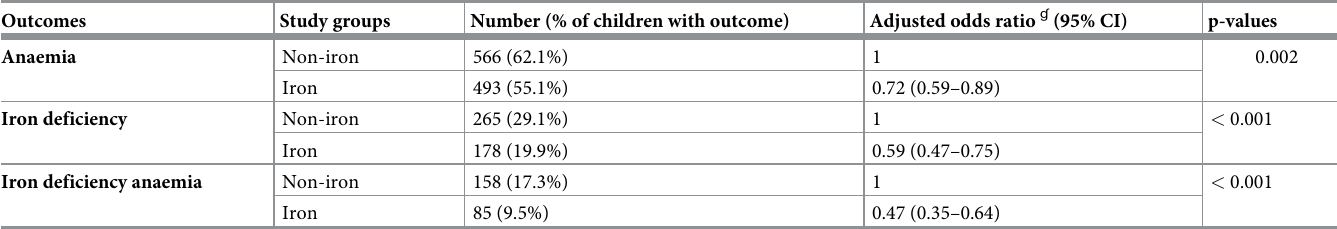
Table 3. Effect of MNP on anaemia and iron status among study